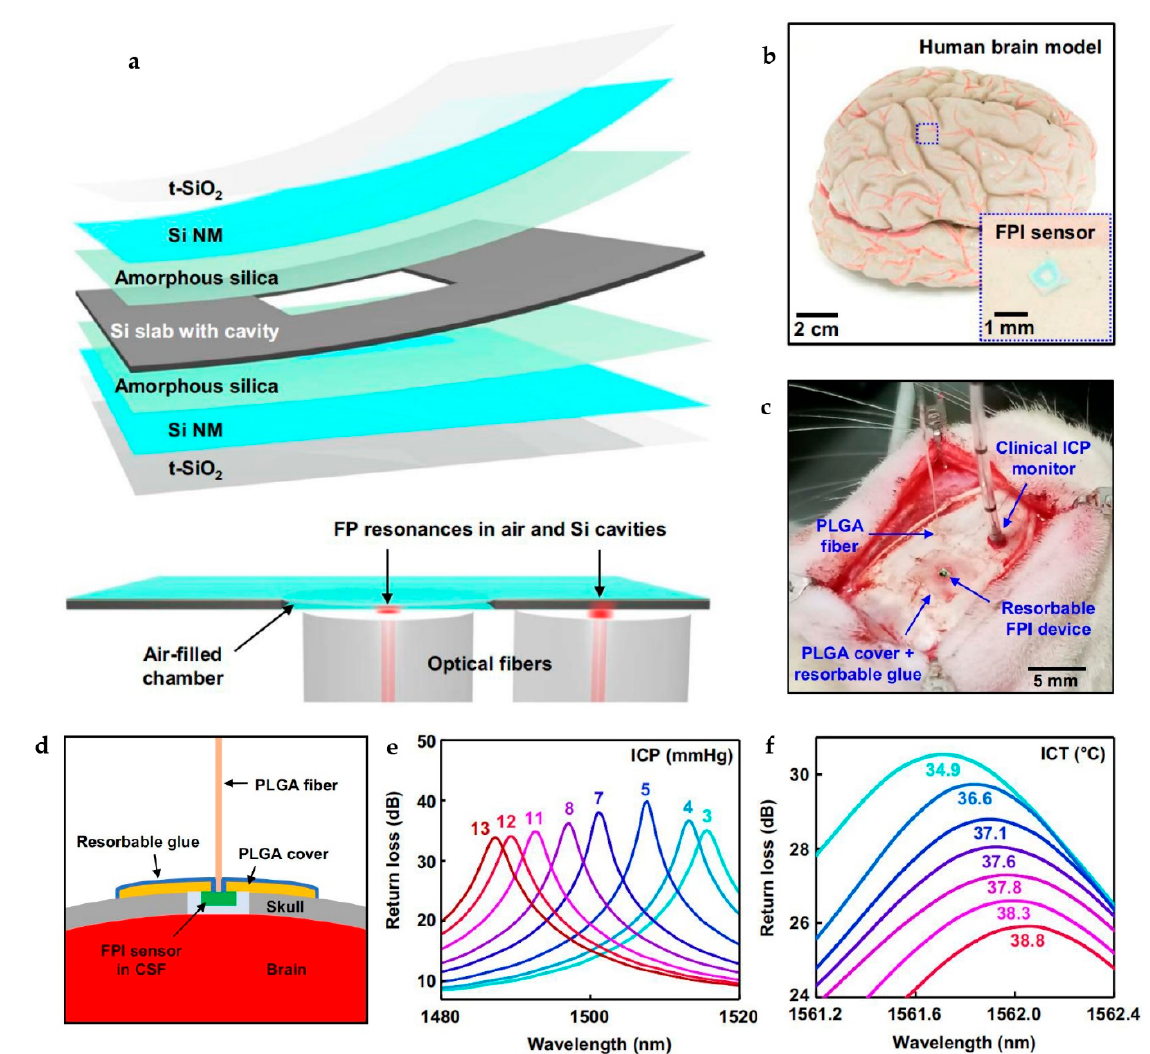
Figure 5. ( a ) Schematic illustration of the key materials and structures of a bioresorbable Fabry–Perot interferometer (FPI) pressure and temperature sensor. ( b ) Optical image of an FPI sensor placed on an adult brain model. A magnified view of the device appears in the inset. ( c ) Optical image of a bioresorbable FPI sensor implanted in the intracranial space of a rat for the monitoring of ICT and ICP. ( d ) Cross-sectional view of the configuration for devices and skull during animal testing. ( e ) Optical spectra obtained from a bioresorbable FPI pressure sensor under different pressure conditions. ( f ) Optical spectra obtained from a bioresorbable FPI temperature sensor at different temperatures. ( a – f ) Reproduced with permission from [10].